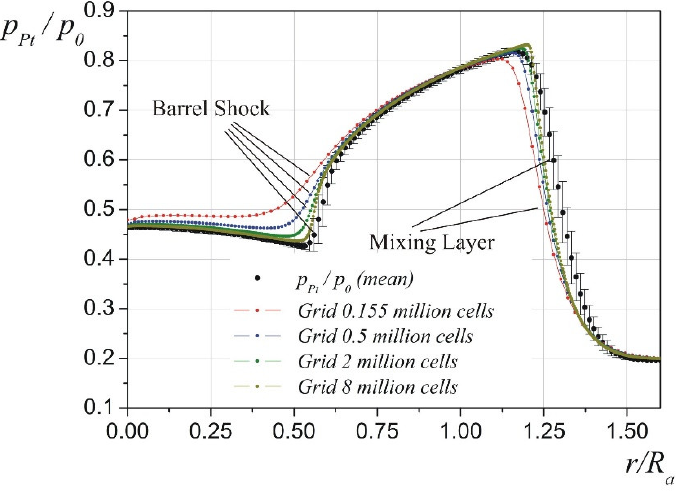
Figure 5. Comparison of calculation and experiment in cross section x/R a = 2.0.